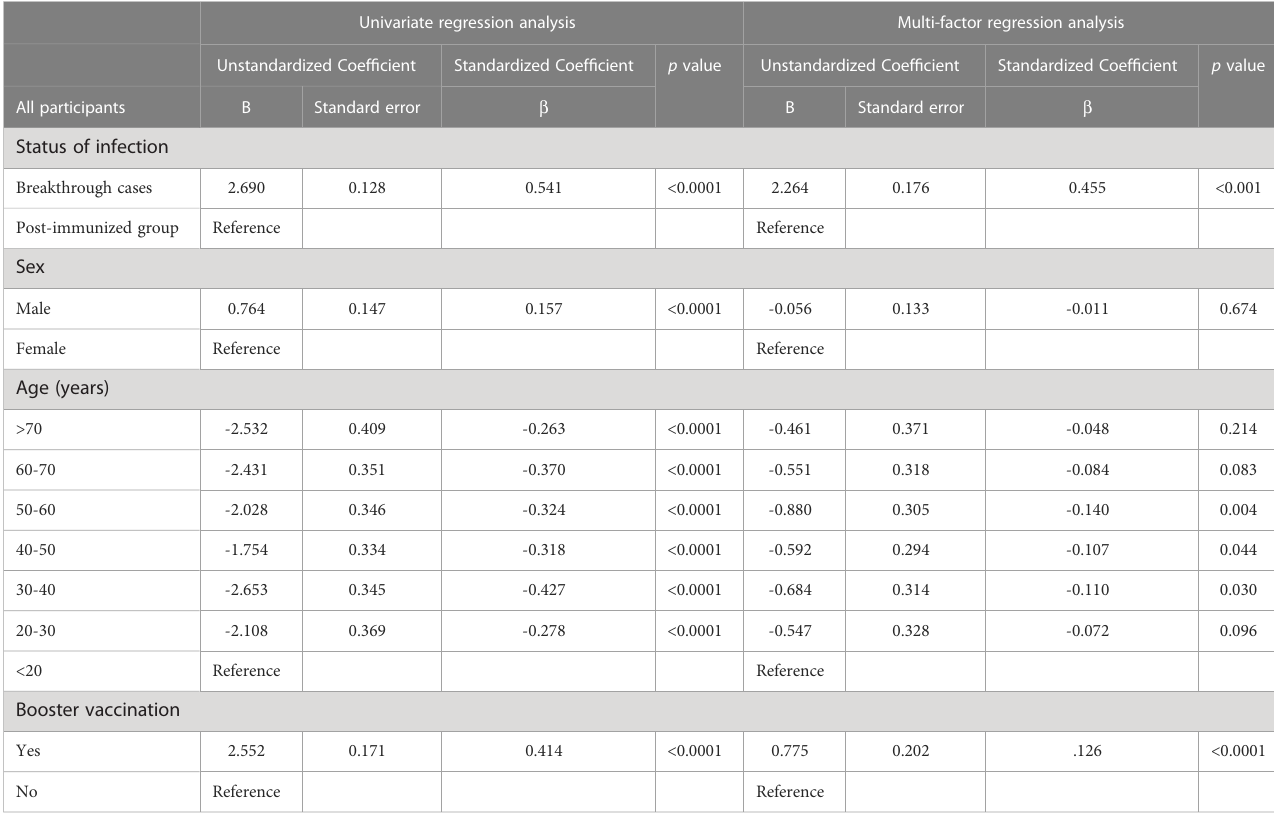
TABLE 2 Linear regression of the factors in fl uencing NAb levels in the whole